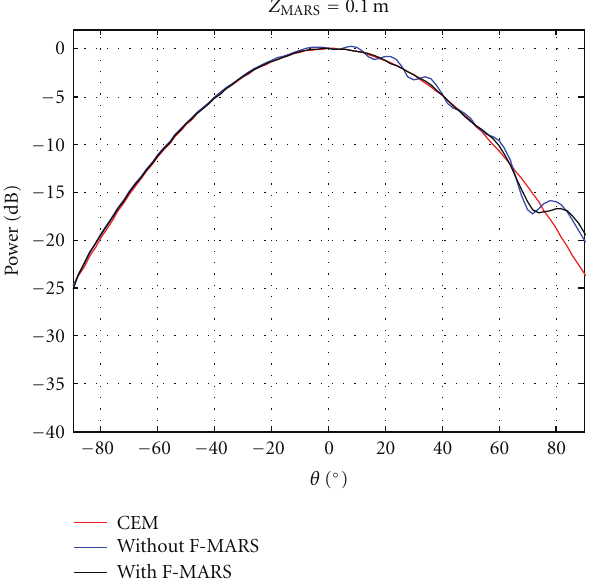
Figure 8: Far-field cut with and without MARS processing. Dis- placement of 10cm.